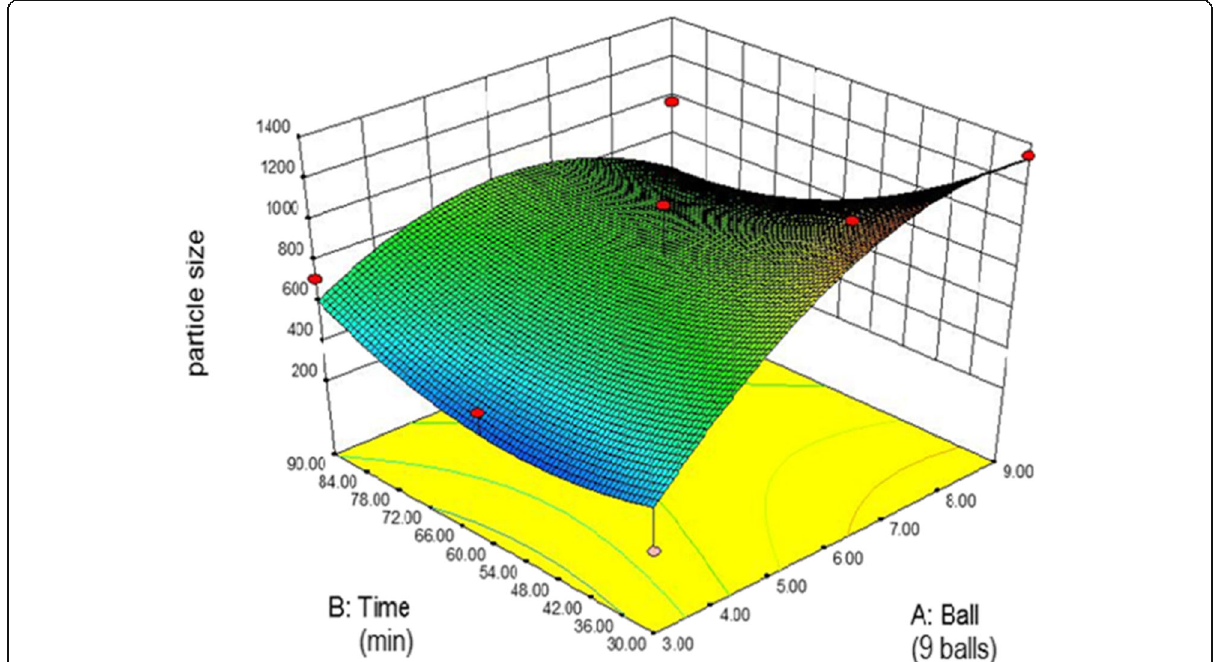
Fig. 4 Response surface curve showing effect of number of balls and time on Particle